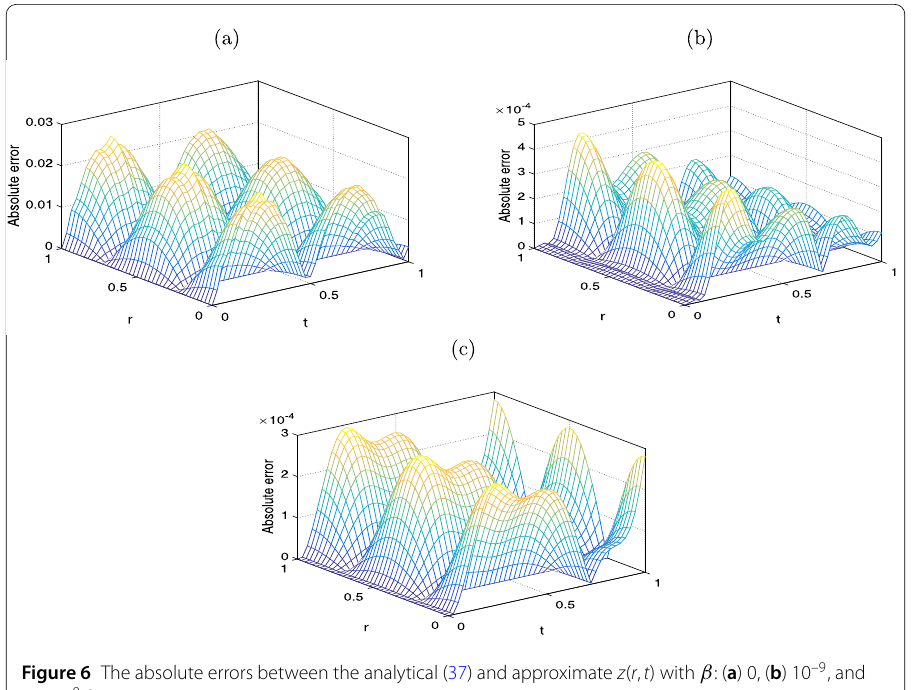
Figure 6 The absolute errors between the analytical (37) and approximate z ( r , t ) with β : ( a ) 0, ( b ) 10 –9 ,